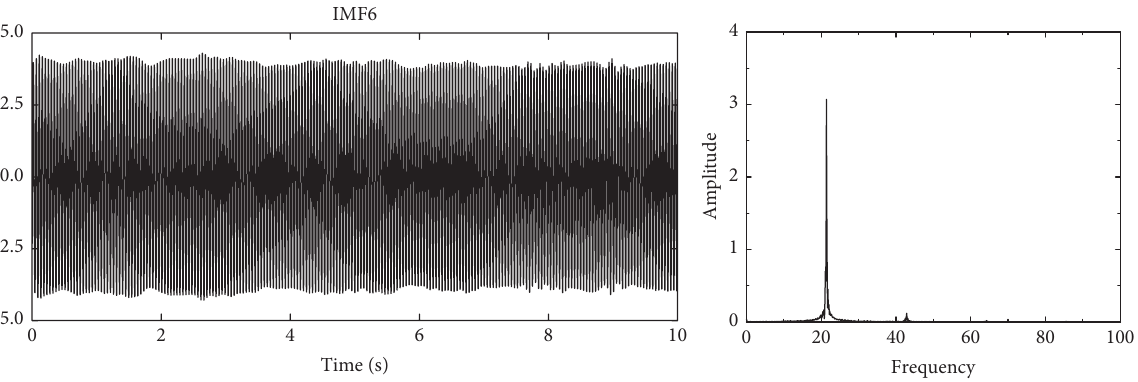
Figure 17: IMF6 and its FFT